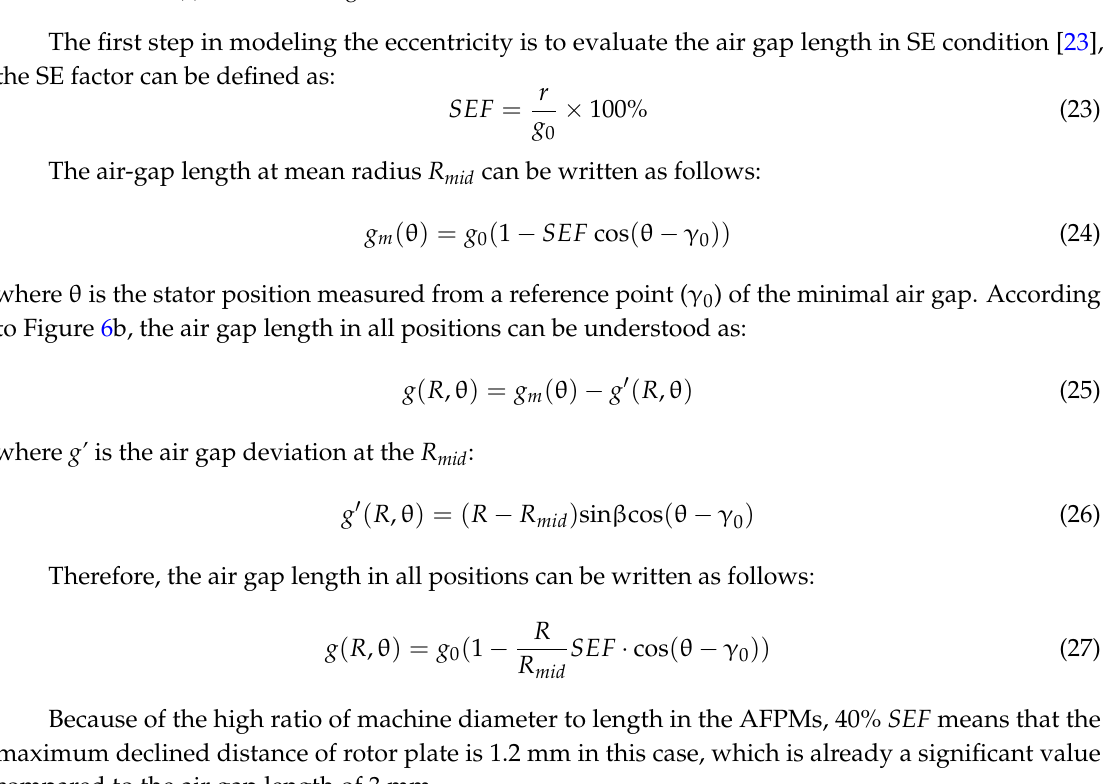
Figure 6. ( a ) Double sided topology of AFPMM machine in 2D plane; ( b ) Static eccentricity (SE) in AFPMs; and ( c ) Detailed configuration of SE.